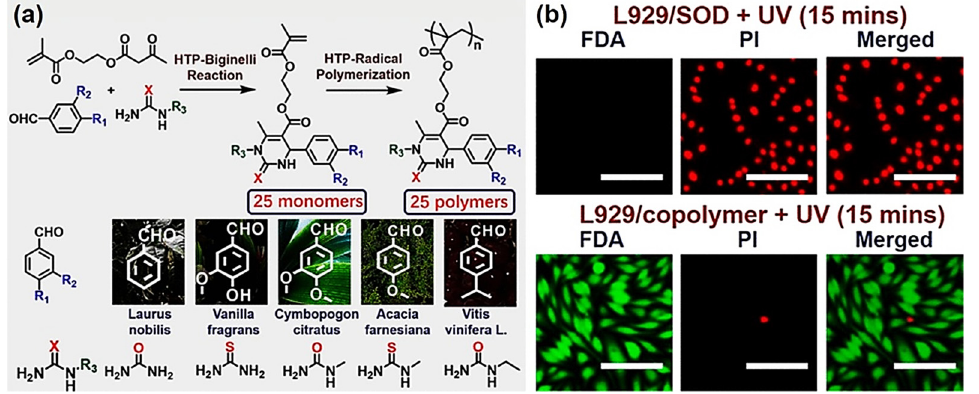
Figure 3. The mini-HTP synthesis of Biginelli polymers and their cell protection along with SOD against UVR: ( a ) HTP methods used to prepare libraries of 25 new monomers and homopolymers; ( b ) fluorescein diacetate/propidium iodide (FDA/PI; green—alive; red—dead) double-staining of L929 cells with UV radiation (15 min) in the presence of SOD (10 mg/mL, up) and copolymer (10 mg/mL, down); scale bar = 100 µm. Reprinted with permission from ref. [26] . Copyright © 2018 American Chemical Society. All rights reserved.